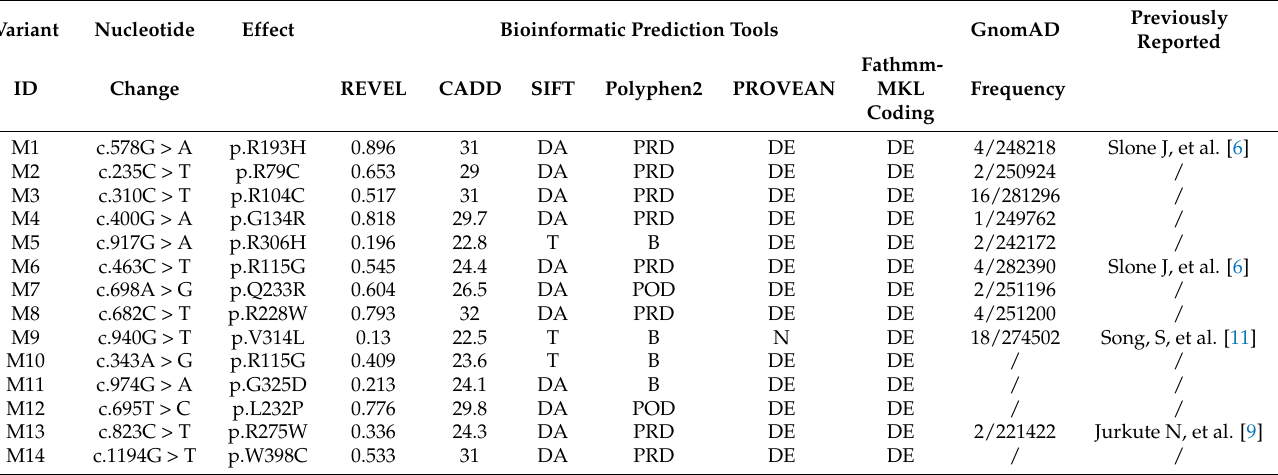
Table 1. Biallelic pathogenic or likely pathogenic FDXR variants in this